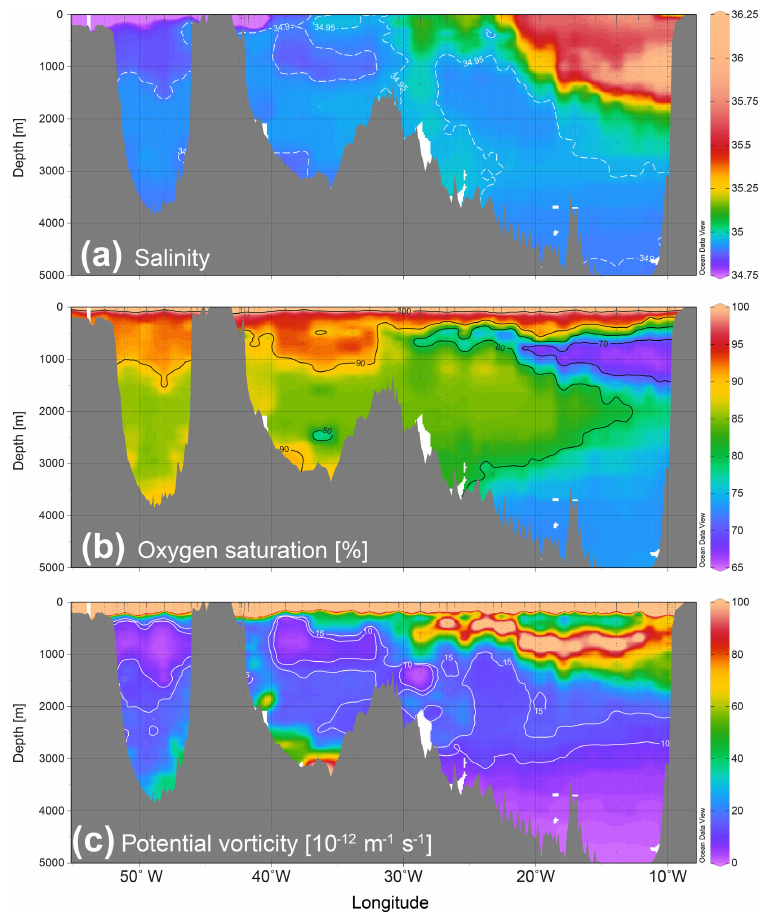
Figure 4. Depth section across the GEOVIDE transect with hydrographic parameters (a) salinity, (b) oxygen (O 2 ) saturation, and (c) potential vorticity (PV). Spreading of Labrador Sea Water, reflected in hydrography by low-salinity, low-PV, high-O 2 signals (panels a , b , and c